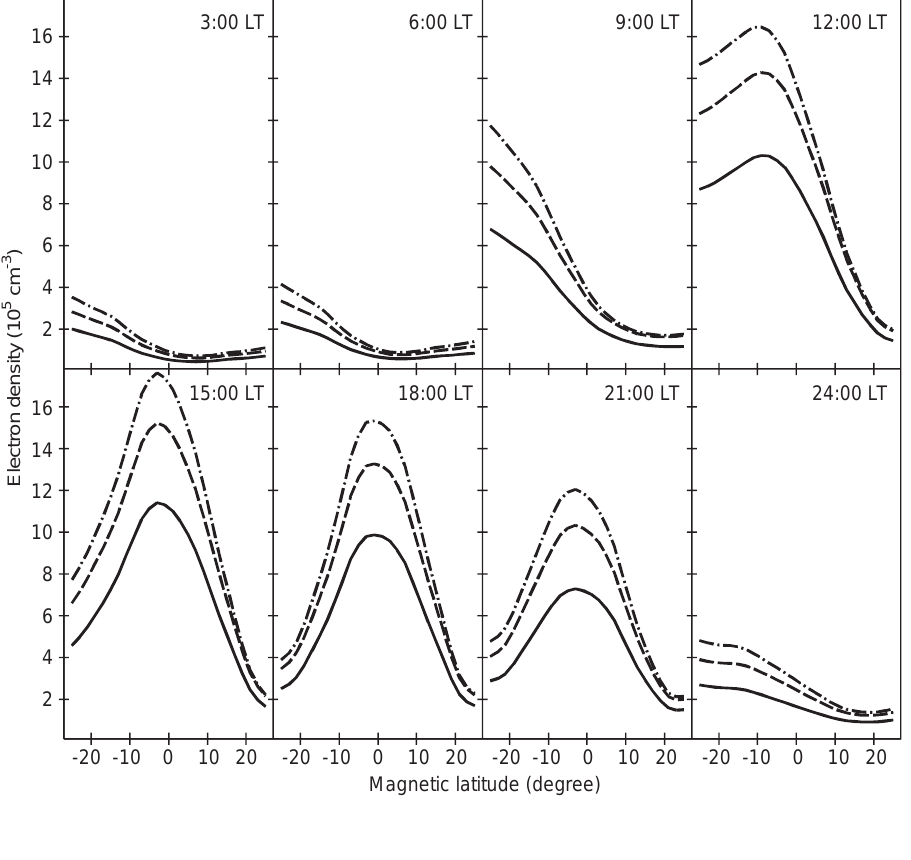
Fig. 8. Latitudinal variations of the modelled electron density, at inter- vals of 3 h, for the December solstice. The solid curves are the same as the short-dashed curves of Fig. 4. The dashed curves and dot- dashed curves are from the calcu- lations in which the neutral densi- ties, given by MSIS86, are multiplied by the factor 1.5 for O, O 2 and N 2 , and for O only, respectively. Other model inputs are the same as for the previous sets